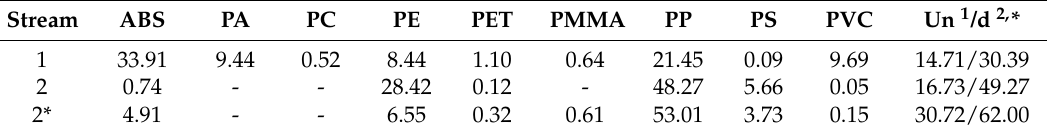
Table 1. Plastic polymers, acrylonitrile-butadiene-styrene (ABS), polyamide (PA), polycarbonate (PC), polyethylene (PE), polyethylene terephthalate (PET), polymethyl methacrylate (PMMA), Stream 1 = manually sorted construction and demolition waste (CDW); Stream 2 = mechanically sorted CDW; Stream 2* = mechanically sorted